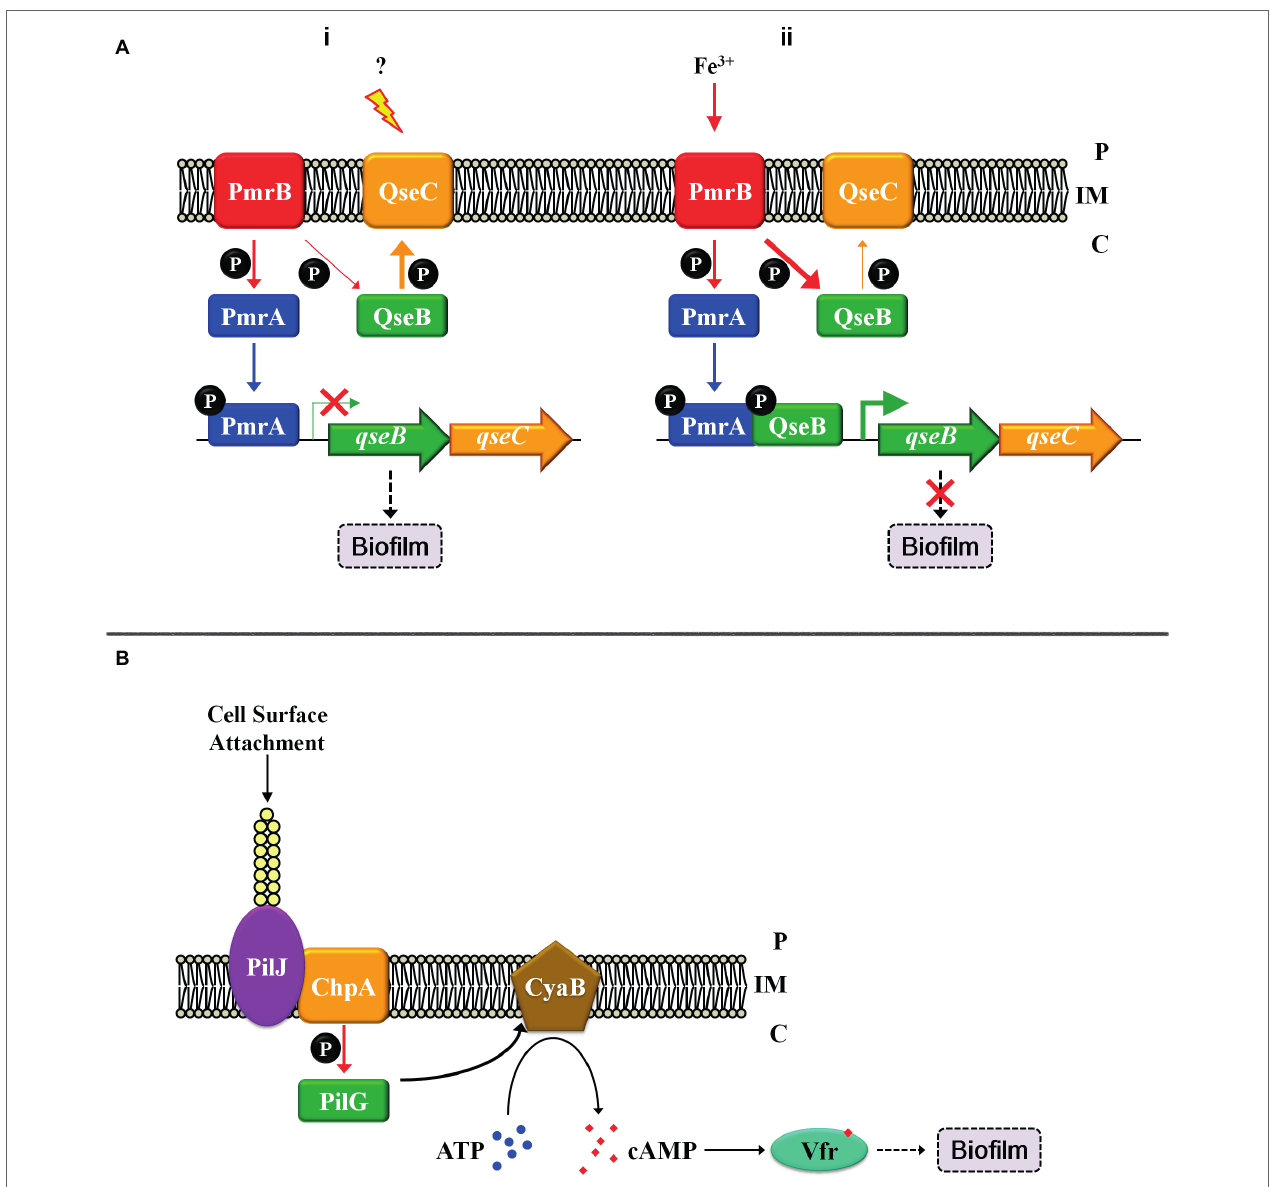
FIGURE 2 | Cross-regulation patterns and the “control system” with TCS. (A) Cross-regulation between PmrB-PmrA and QseC-QseB. (i) The regulatory pattern in QseC-activated conditions; (ii) The regulatory pattern in PmrB-activated conditions. (B) Solid surface signal activates TCS ChpA-PilG by TFP. Thick arrows indicate robust regulation, and thin arrows represent weak regulation. Inner membrane (IM). Periplasm (P), cytoplasm